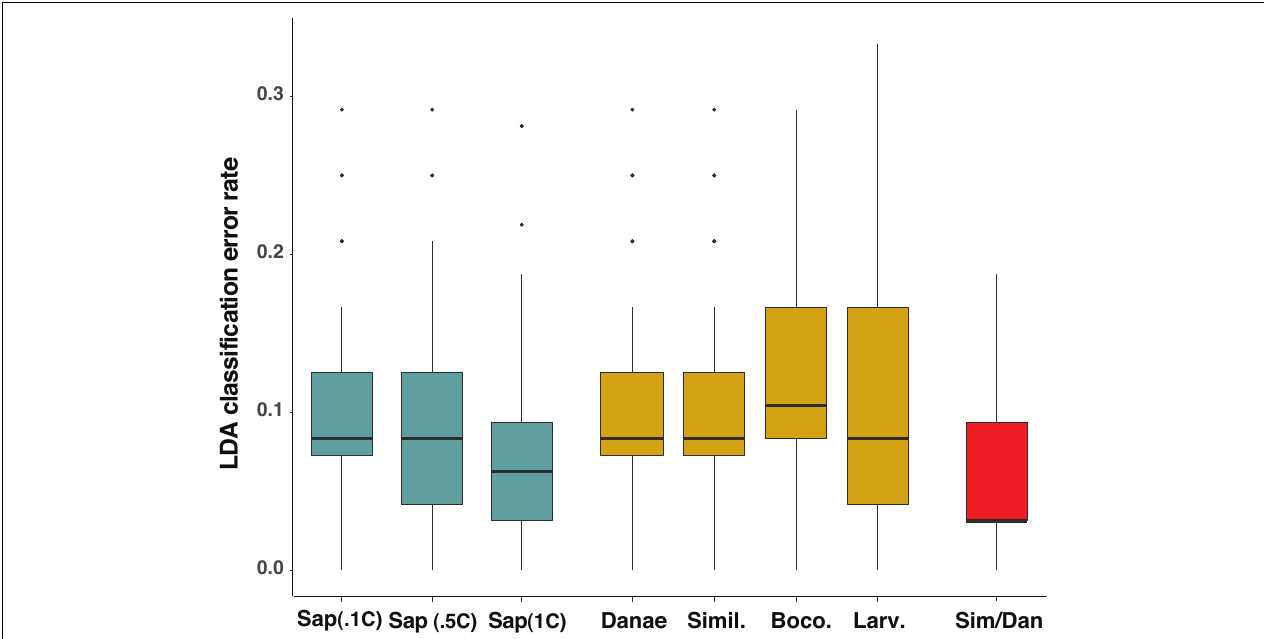
FIGURE 6 | Linear discriminant analysis (LDA) classification error rates for different reference species, data resolutions, and groupings. Median error rates (thick black line within boxes) for LDA models run with C. sapidus (Sap.) as a reference are plotted in blue, with each group representing a different level of Tm resolution: RFU values every 0.1 ◦ C (Sap.1C); 0.5 ◦ C (Sap.5C); and 1 ◦ C resolution (Sap 1C). Gold boxes represent median classification error for LDA models in which the four other Callinectes species were used as references: C. danae (Danae), C. similis (Simil.), C. bocourti (Boco.), and C. larvatus (Larv.). The red box (Sim/Dan) represents the median error rate when C. similis and C. danae were combined into one group for species assignment in LDA. Classification error data for each reference or temperature resolution setting run in LDA are the result of 100 random simulations of the data split into training and validation sets. Box and whisker plots present the median error rates (thick line in box), 1st and 3rd quartiles (top and bottom of the box), 1.5x the interquartile range (IQR; the whiskers) and outlier points (individually plotted